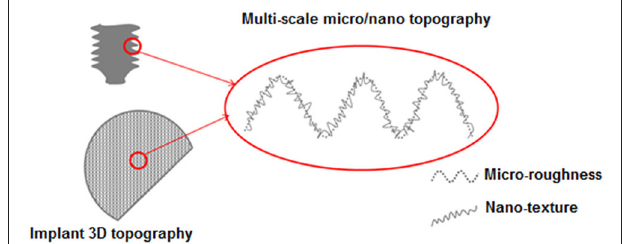
FIGURE 2 | Schematic representation of the multi-scale surface